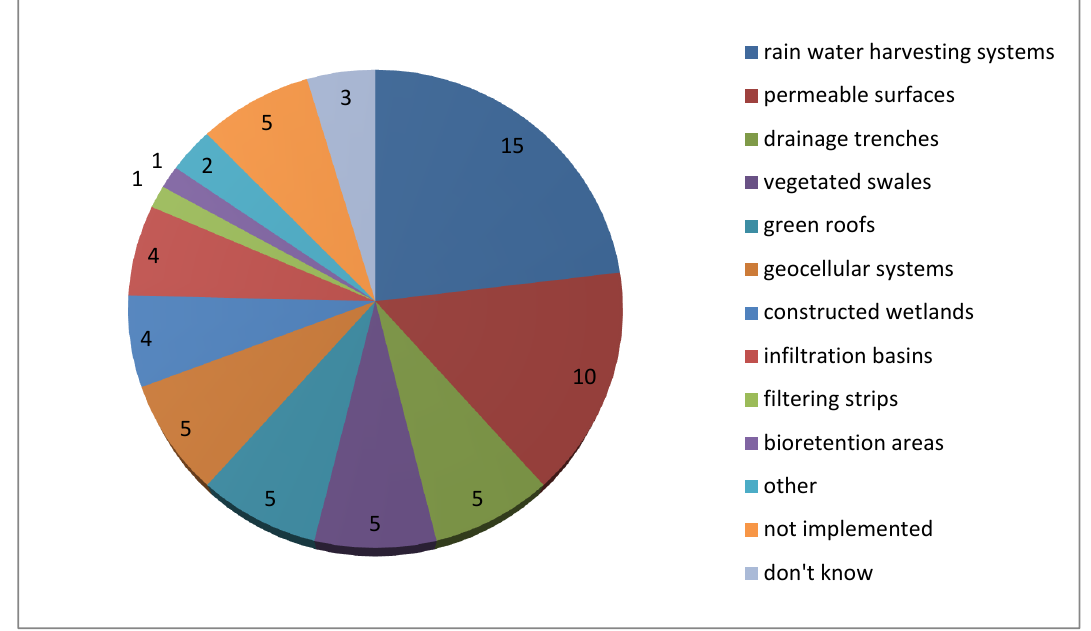
Figure 4. Type and number of WrGIs / SuDSs implemented in the four investigated regions.